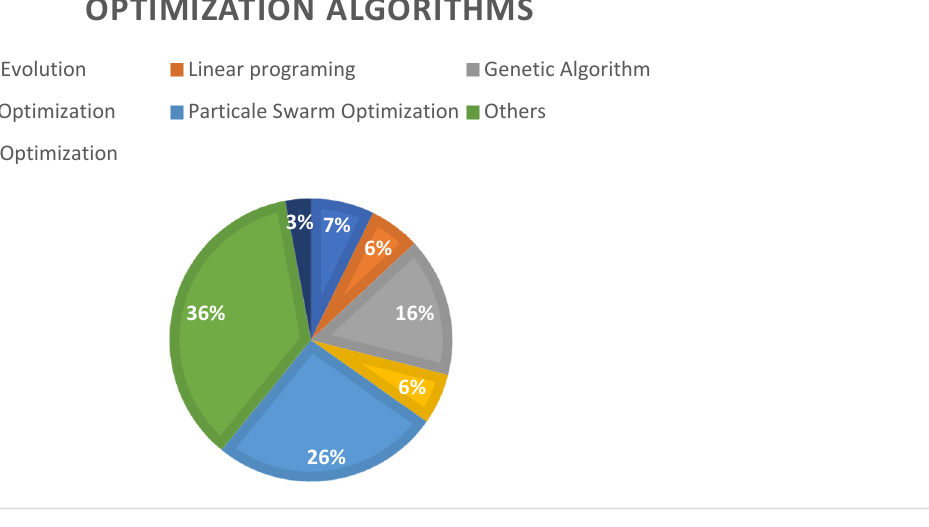
Figure 13. Optimization algorithms ratios.